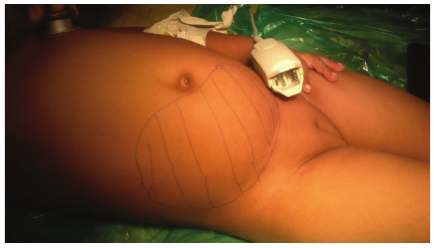
Figure 1: Clinical image with the outlining of the mass.